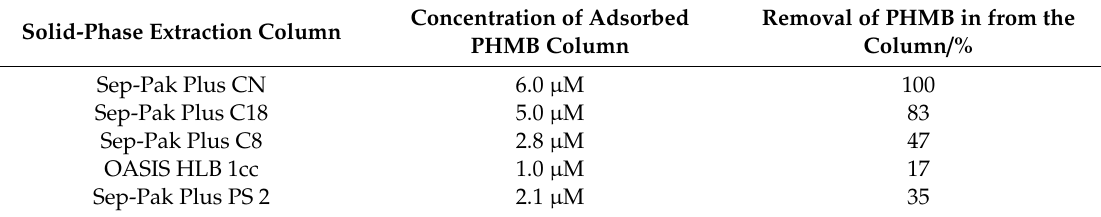
Table 1. Evaluation of the removal of PHMB by using several solid-phase extraction columns. Concentration of Adsorbed PHMB Removal of PHMB in from the Solid-Phase Extraction Column PHMB Column Column / % Column Column Sep-Pak Plus